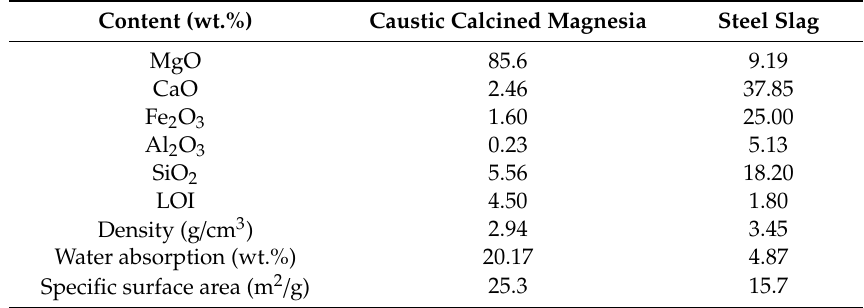
Table 1. Chemical compositions and physical properties of caustic calcined magnesia and steel slag.